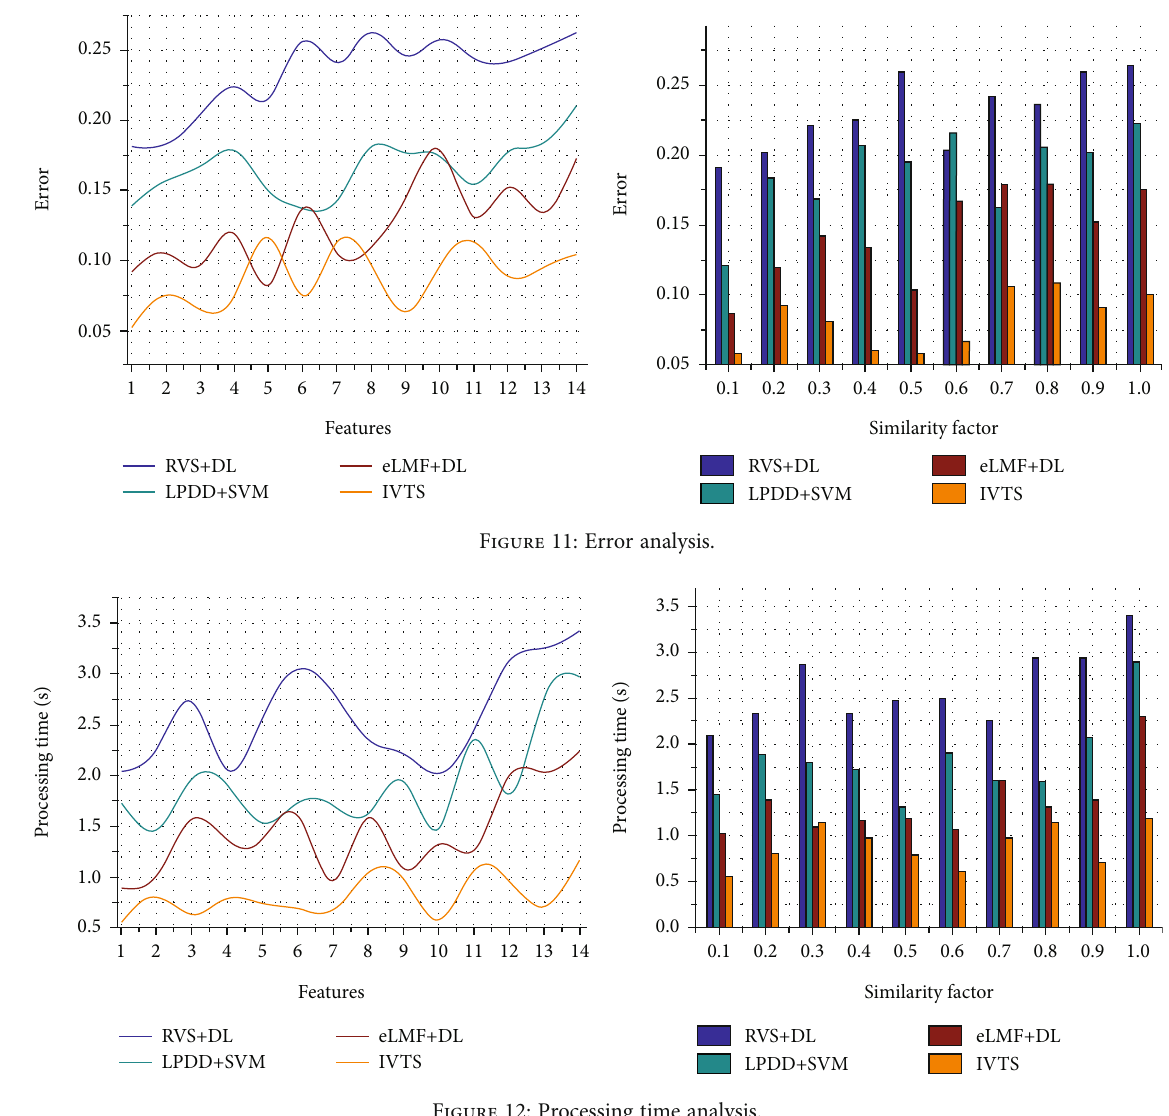
Figure 12: Processing time